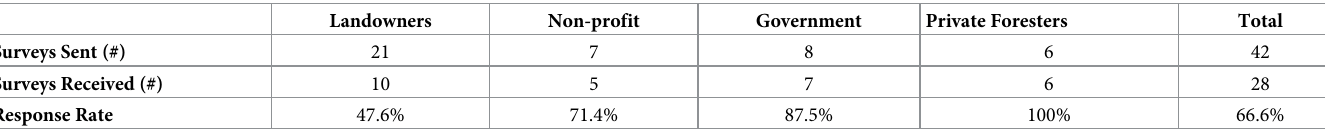
Table 4. Response rate for the second round of SWOT